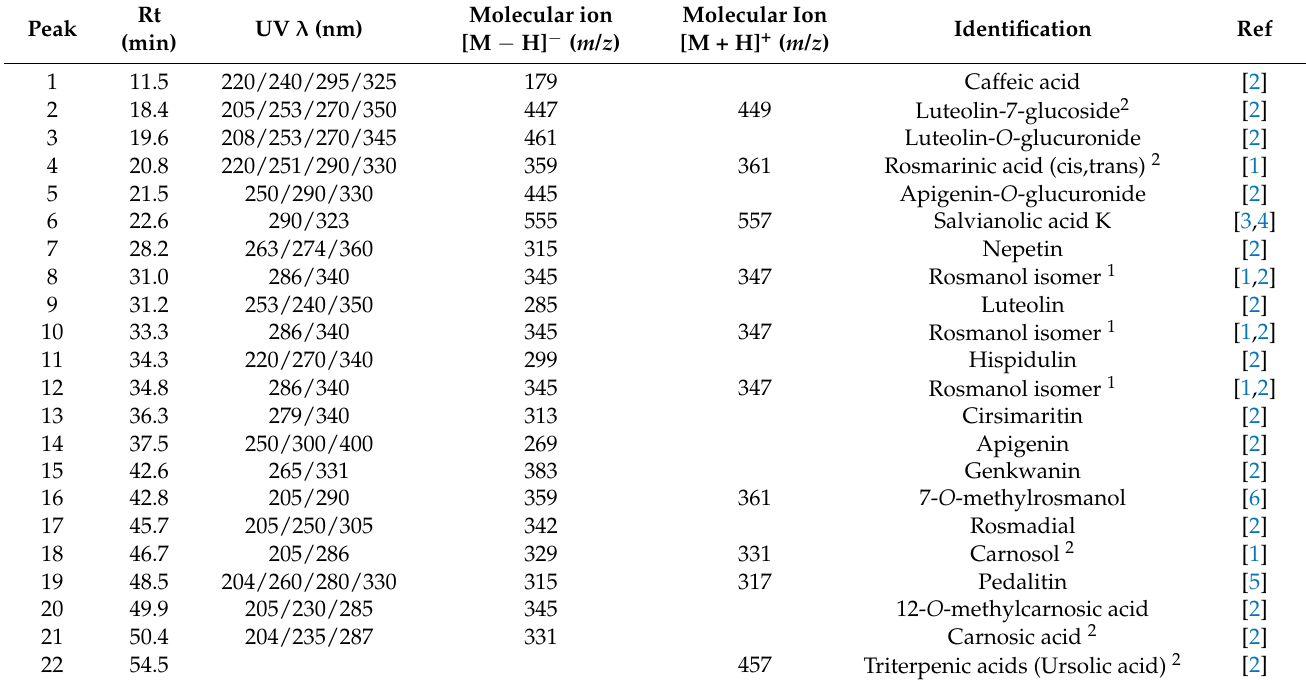
Table 3. Retention time, wavelengths of maximum absorption in the ultraviolet (UV)-visible (VIS) region, mass spectra data, and compounds identification in S. officinalis .